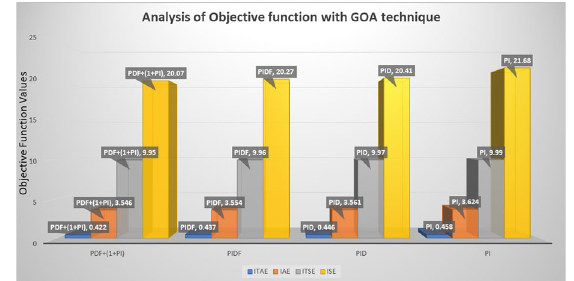
Fig. 4 Study of the different objective functions with GOA